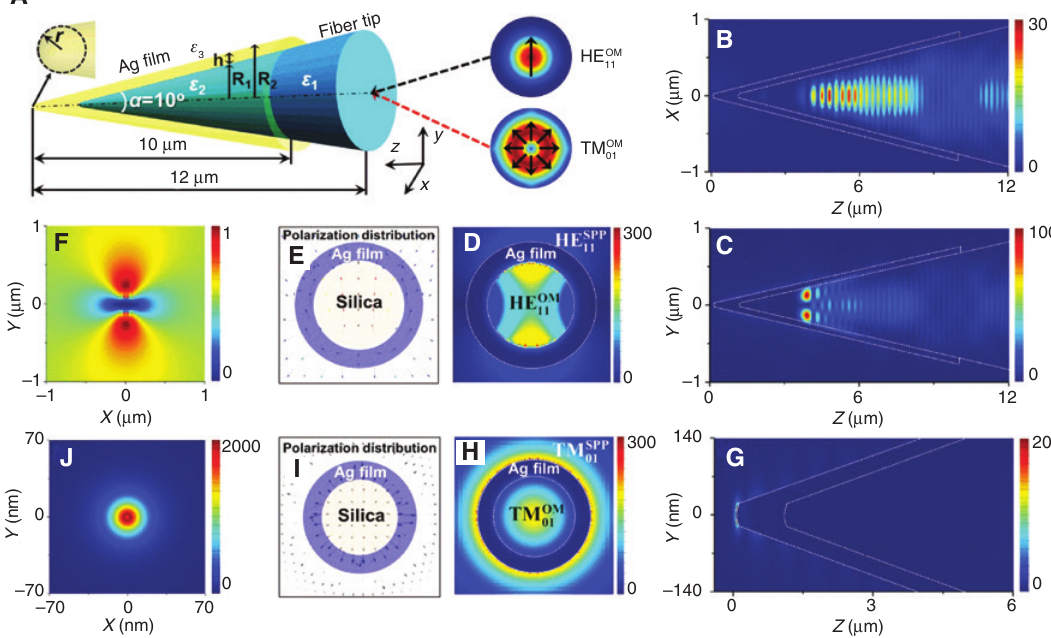
HE and OM TM . Figure 2: Visualization of the internal illumination process via OM 11 01 (A) FDTD model representing the Ag-coated fiber tip with α = 10 ° , and the tip radius r = 20 nm. Electric field intensity distributions in x-z HE along an Ag-coated fiber tip excited via OM HE with linear polarization direction along y -axis. (D) Transverse (B) and y-z (C) planes of SPP 11 11 = 312 nm with wave vector matching condition to be satisfied. HE and SPP HE at the position of R electric field intensity distributions of OM 1 11 11 HE at 2 nm underneath the Ag-coated (E) Polarization distributions corresponding to (D). (F) Electric field intensity distribution of SPP 11 fiber tip. (G) Electric field intensity distributions in y-z plane along an Ag-coated fiber tip excited via OM TM . (H) Transverse electric field 01 = 180 nm with wave vector matching condition to be satisfied. (I) Polarization TM and SPP TM at the position of R intensity distributions of OM 01 01 1 TM at 2 nm underneath the Ag-coated fiber distributions corresponding to (H). (J) Electric field intensity distribution of SPP 01